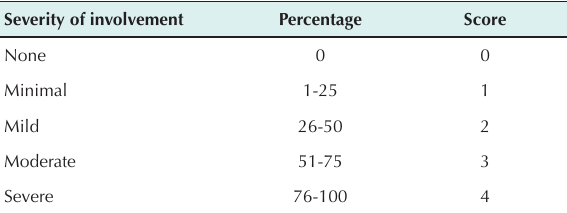
Table 1. Scope Scoring System of COVID-19 Based on CT Scan Findings Severity of involvement